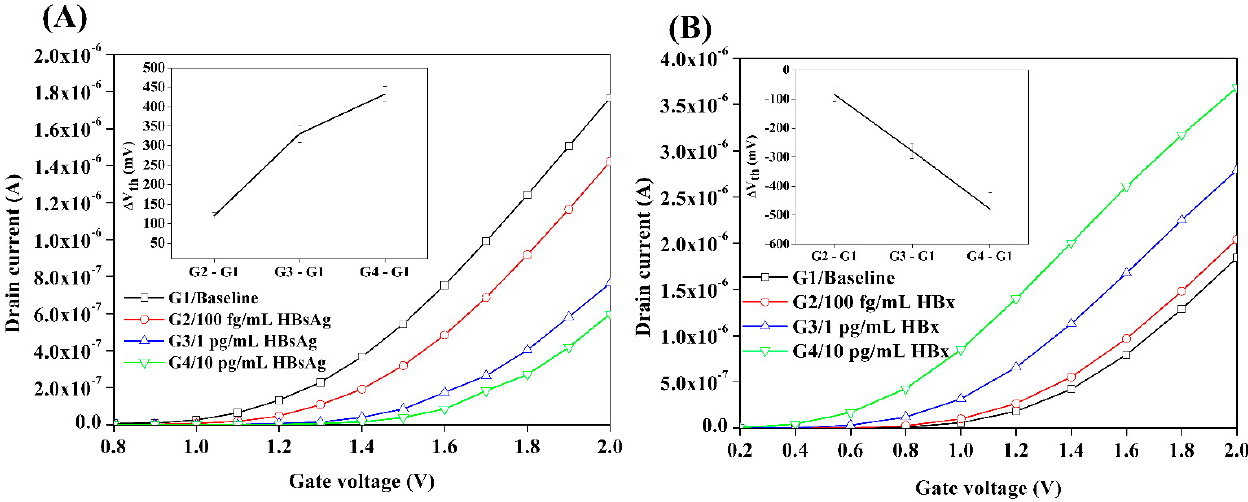
Figure 4. The electrical properties of pSiNWFET response on the various concentration of HBsAg and HBx. ( A ) The electrical property of the pSiNWFET was conducted at a fixed drain voltage (V D = 0.5 V) and gate voltage sweeping from 0.8 V to 2.0 V. The black line indicates baseline (G1) of the pSiNWFET; red line, blue line, and green line indicate the electrical property of pSiNWFET after being incubated with 100 fg/mL HBsAg (G2), 1 pg/mL HbsAg (G3), and 10 pg/mL HBsAg (G4), respectively. The inset figure shows changes in the threshold voltage after each sample’s incubation, and the error bar indicates standard error from three devices. ( B ) The electrical property of the pSiNWFET was conducted at a fixed drain voltage (V D = 0.5 V) and gate voltage sweeping from 0.2 V to 2.0 V. The black line indicates baseline (G1) of the pSiNWFET; red line, blue line, and green line indicate the electrical property of pSiNWFET after being incubated with 100 fg/mL HBx (G2), 1 pg/mL HBx (G3), and 10 pg/mL HBx (G4), respectively. The inset figure shows changes in the threshold voltage after each sample incubation, and the error bar indicates standard error from three devices.